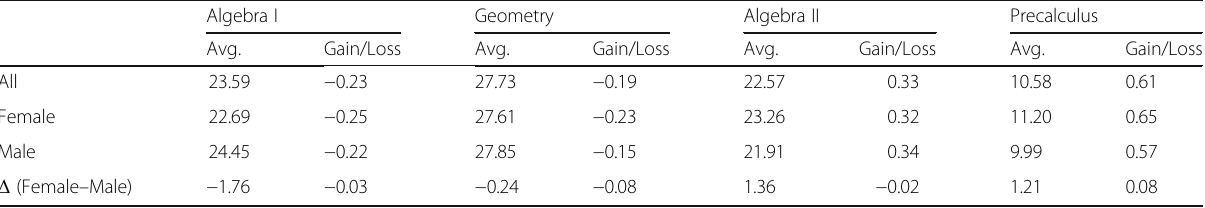
Table 5 Six-year average enrollment rates and gain/loss of enrollment by gender in required and selective mathematics courses Algebra I